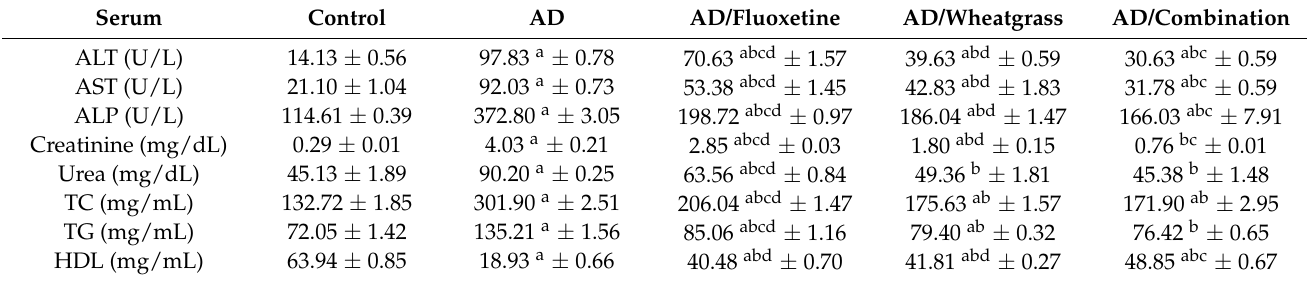
Table 2. Effect of fluoxetine, wheatgrass, or their combination on serum alanine aminotransferase (ALT), aspartate aminotransferase (AST), alkaline phosphatase (ALP), creatinine, urea, total cholesterol (TC), triglycerides (TG), and high- density lipoprotein